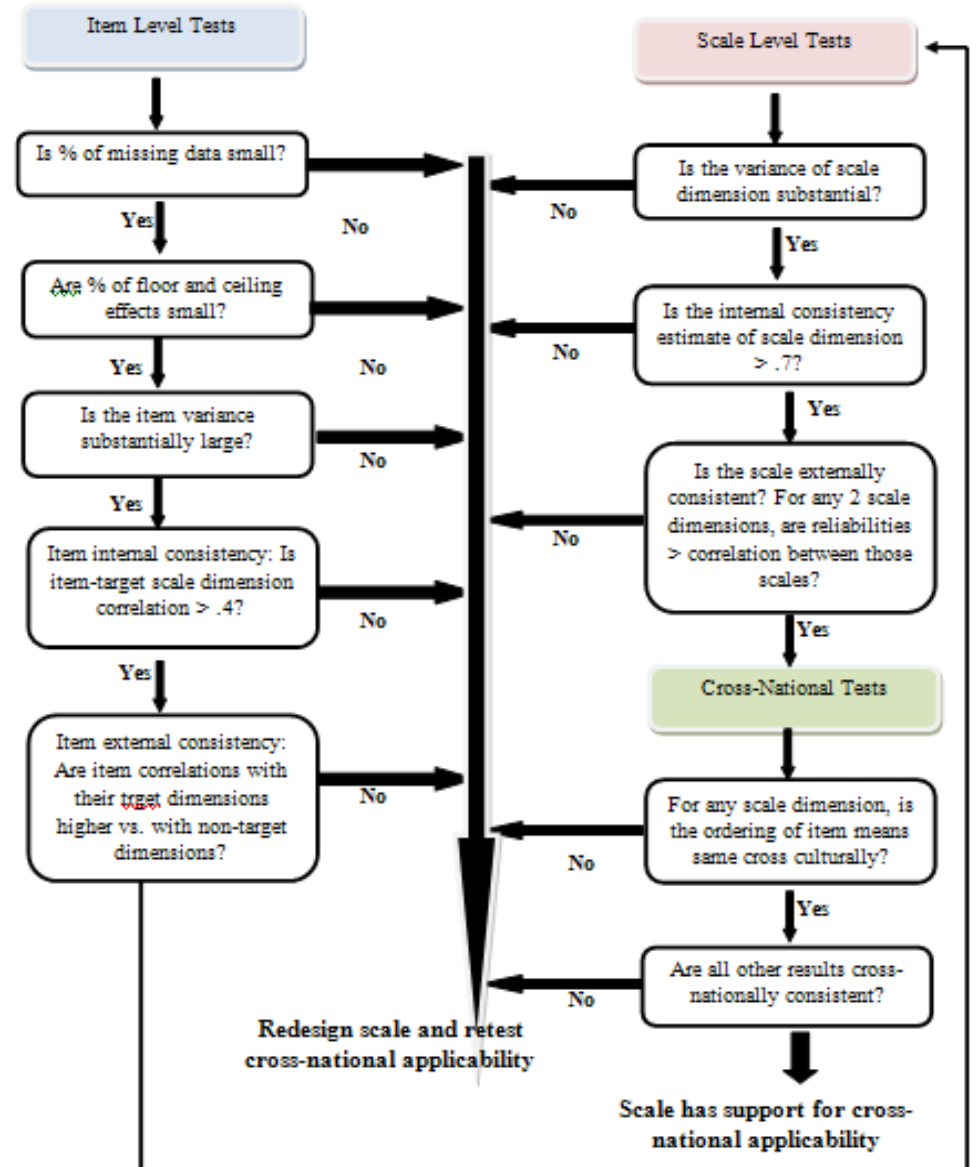
Fig. 1. Steps for establishing cross-national scale applicability in small